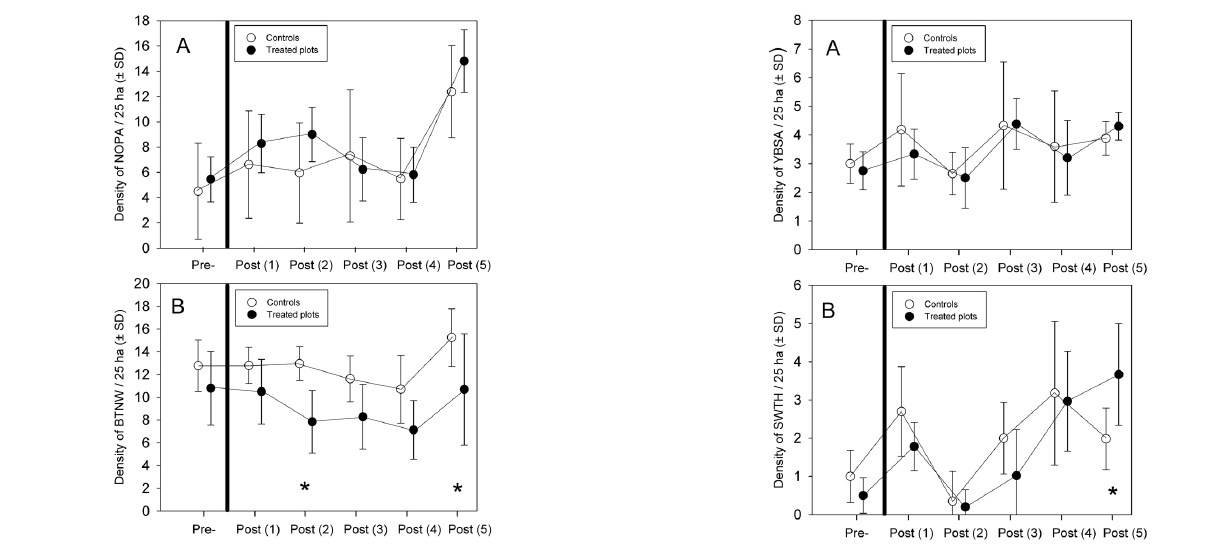
Table 3 . Linear and linear mixed models relating bird density to treatment (selection harvesting), year, and their interaction. Values in bold indicate significant effects, i.e., P -values < 0.05. Species Predictors DF Black-throated Green Warbler